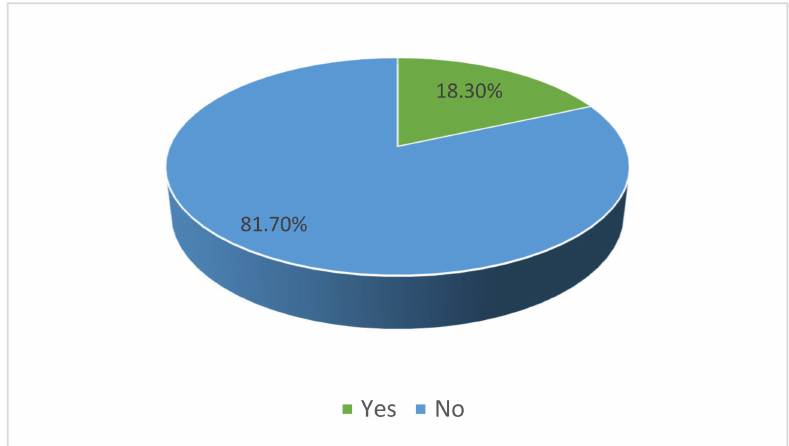
Figure 4. Use of RES technology in the households. Source: authors’ research.